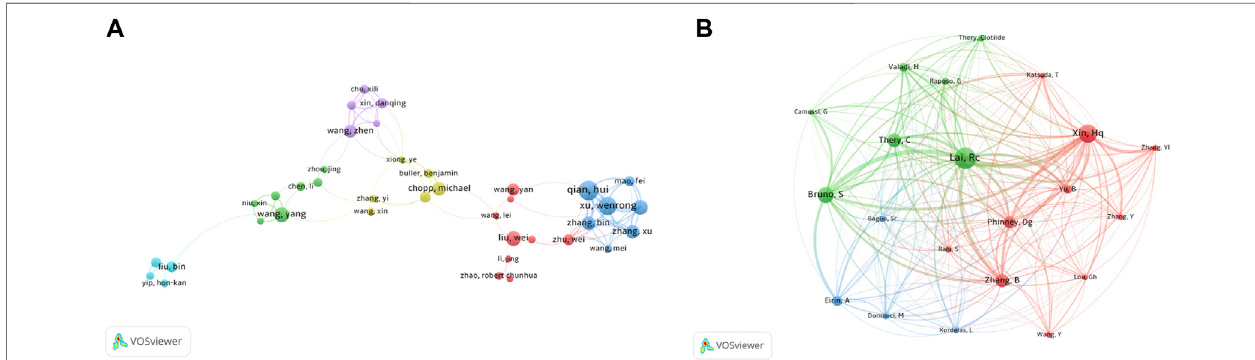
FIGURE 5 | Analysis of authors. (A) Network map of co-authorship between authors with more than fi ve publications. (B) Network map of co-cited authors with more than 150 citations.